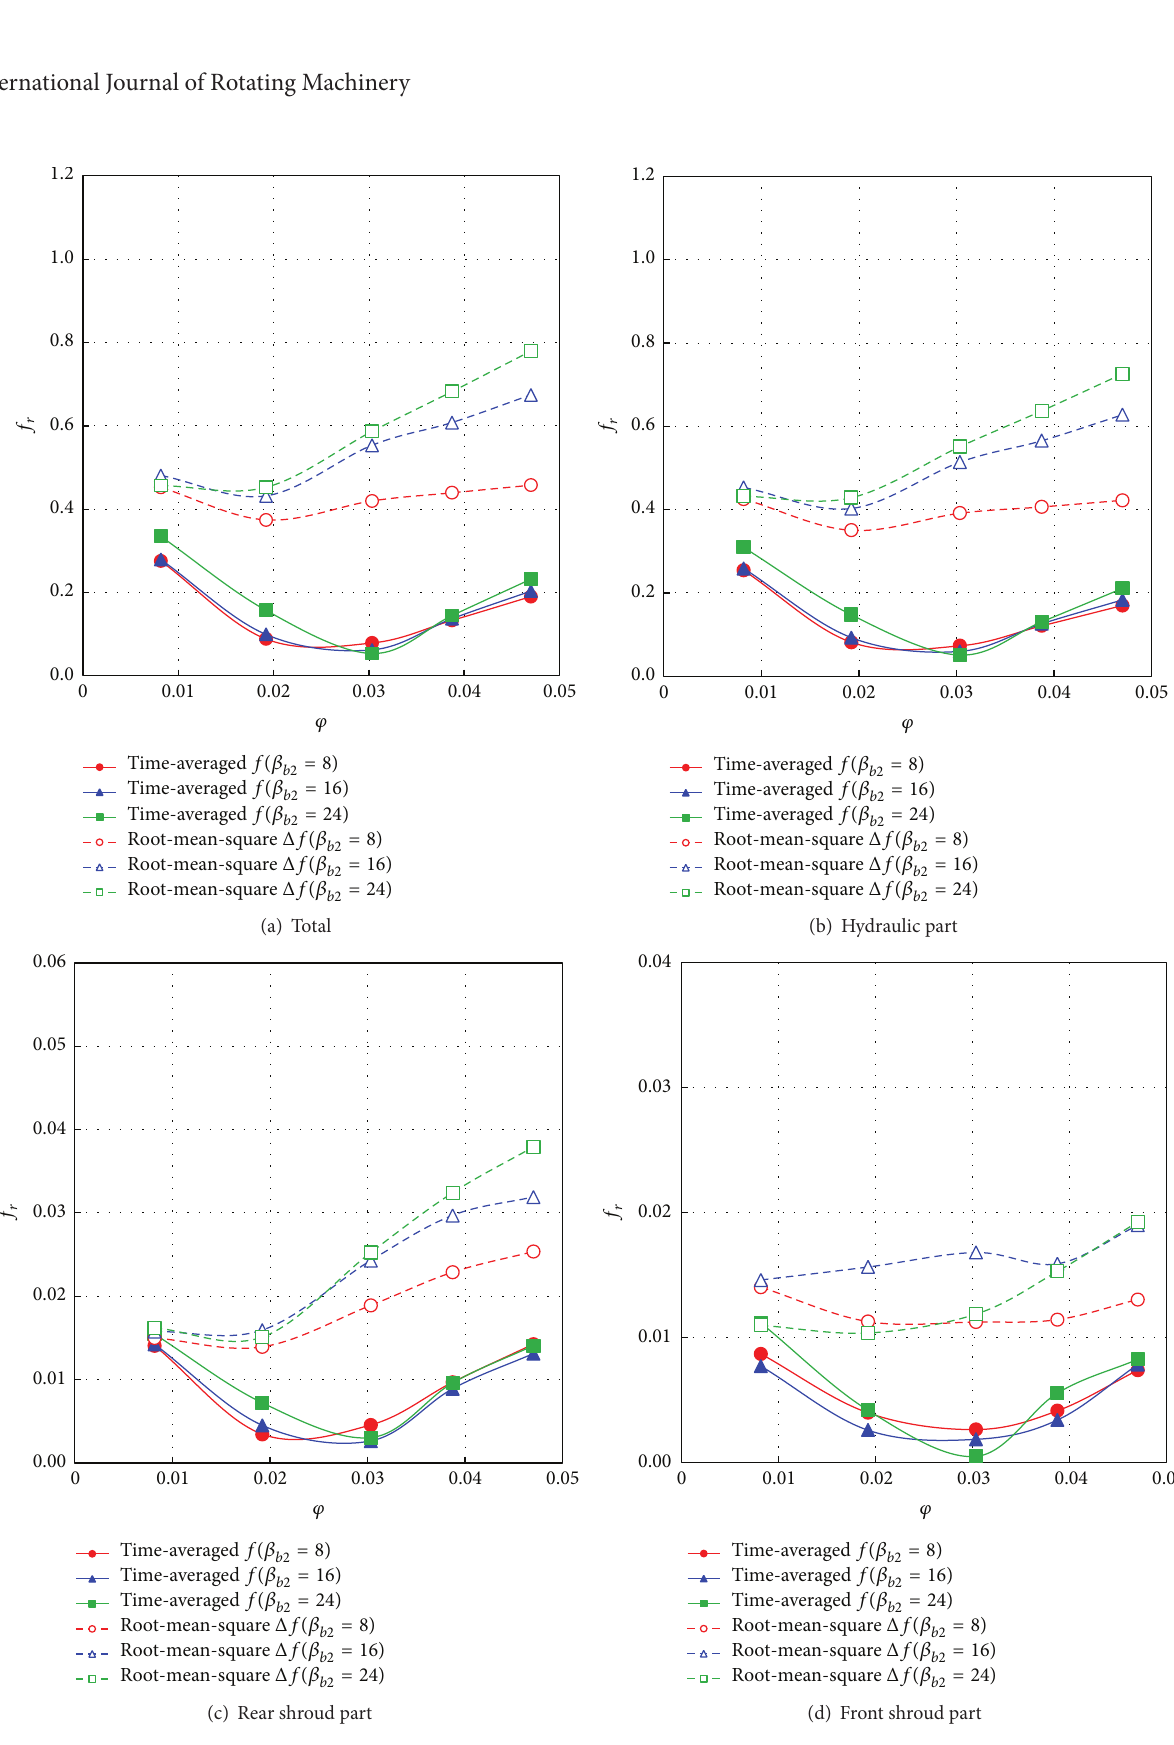
Figure 8: Radial thrust coefficient ( 𝑓 𝑟 ) on each part as functions of flow rate coefficient ( 𝜑